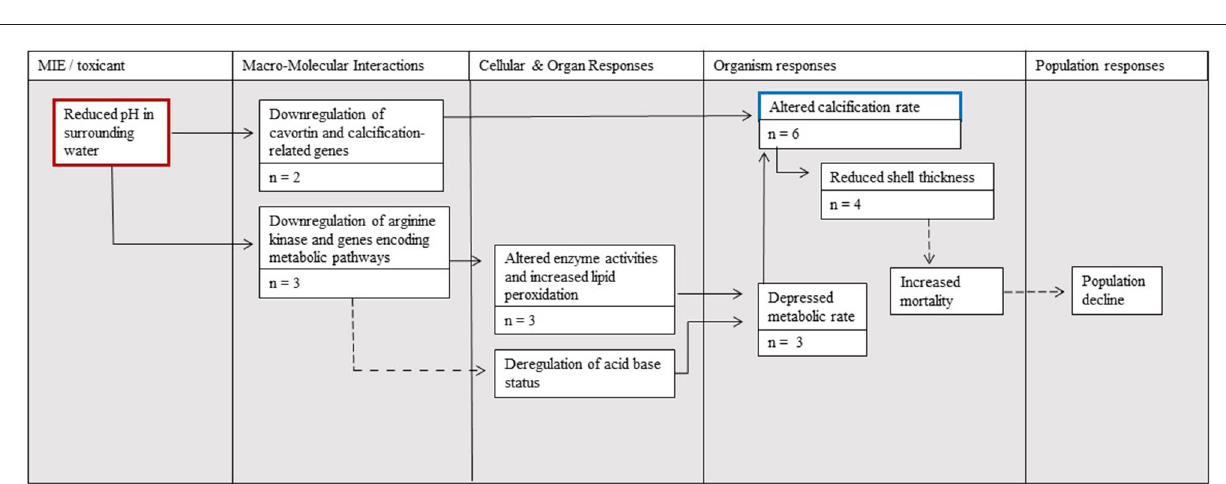
acidification ( Figure 4 ). In this application of the